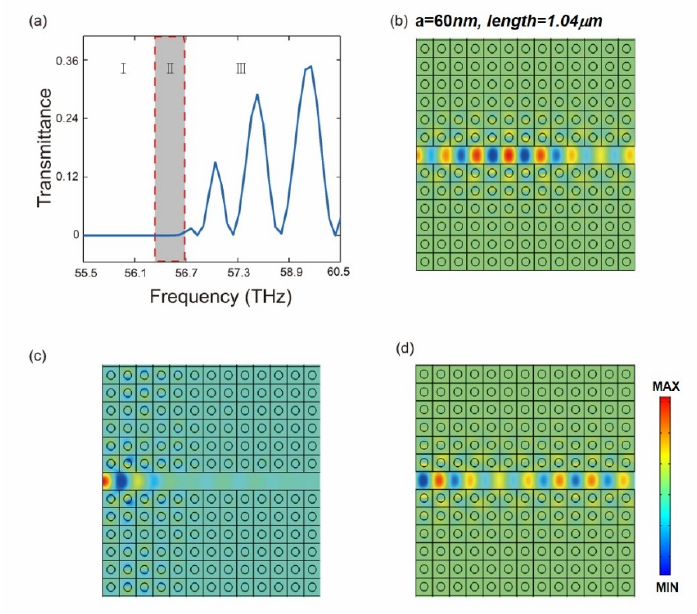
Figure 5. Distinction between backward propagation, forbidden band and forward propagation. ( a ) Transmittance of backward propagation, forbidden band and forward propagation; ( b – d ) are the light field of backward propagation, forbidden band and forward propagation, respectively. The pitch of the metamaterial in ( a – c ) is 1040 nm × 770